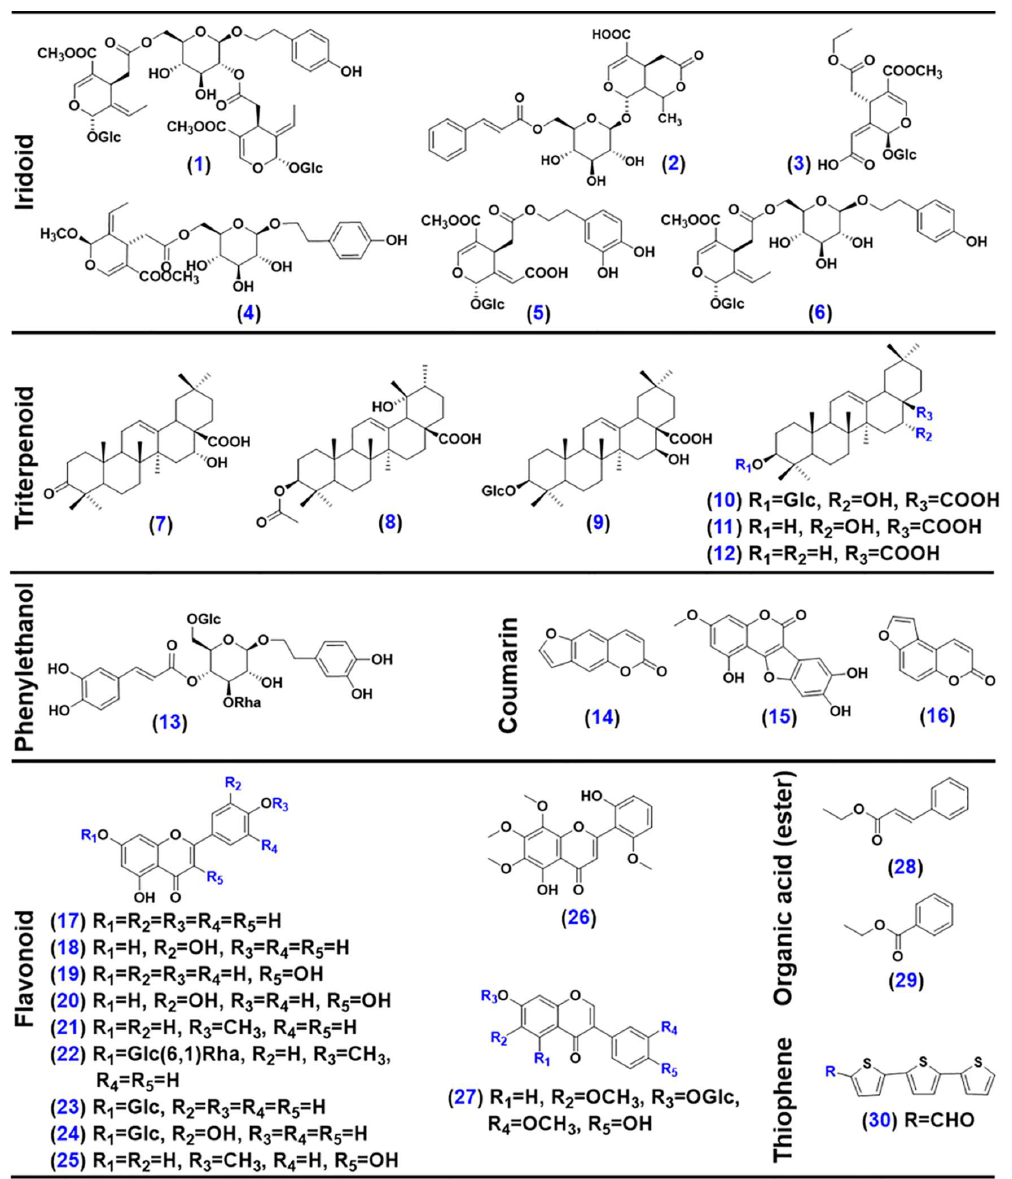
Figure 1. Chemical structures of 30 reference compounds, representative of seven different categories of plant secondary metabolites that were ever reported from Ligustri Lucidi Fructus and Ecliptae Herba.